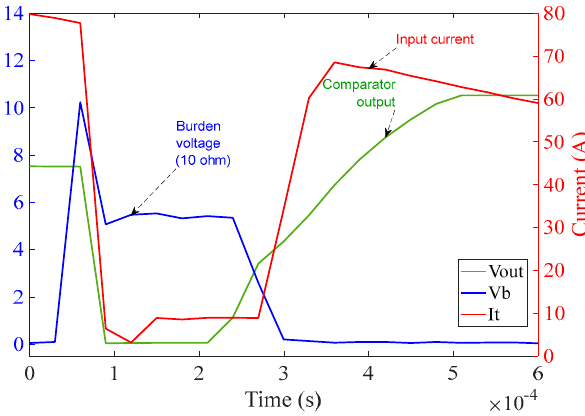
Figure 26. Burden voltage across 10 Ω burden circuit at 90 A (rms) input current at intermediate dip.